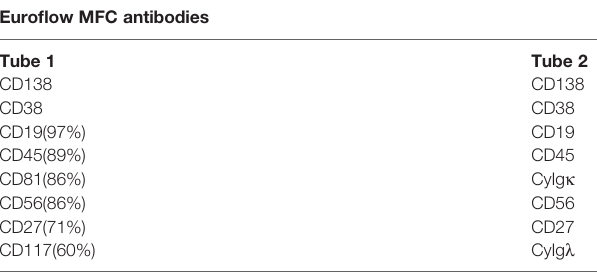
TABLE 1 | Euro fl ow antibody markers used in the 2 tube